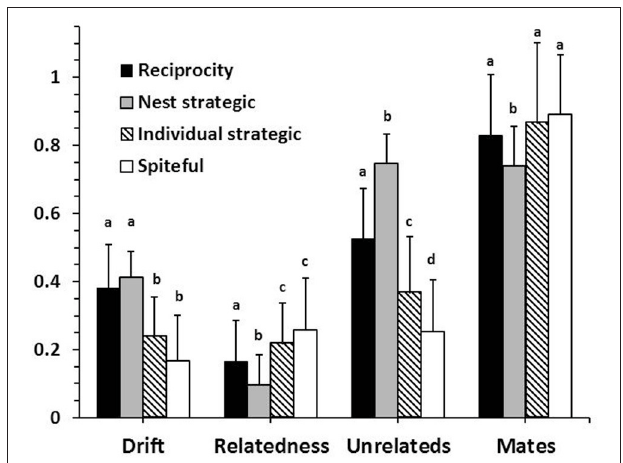
FIGURE 7 | Mean ( ± SD) colony genotypes with and without cheating being possible. Drift is the mean level of acceptance on unrelated individuals. Relatedness is the mean between workers in a nest. The mean numbers of unrelated individuals in a nest and queen mates are given as proportional values relative to the maximum possible. Letters indicate means within categories that are not significantly different by a Bonferroni-Dunn post-hoc